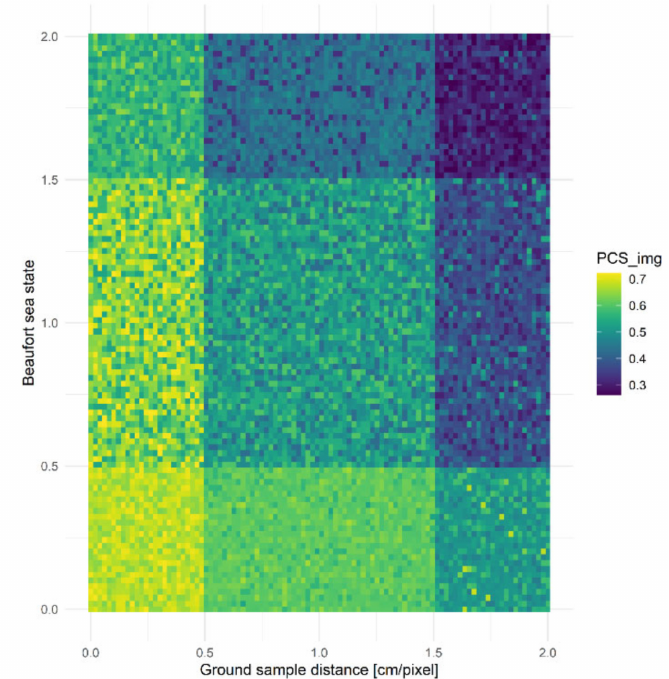
Figure 4. Interaction of ground sample distance (GSD) and Beaufort sea state (BSS) as predictors of the proportion of correct selections per image